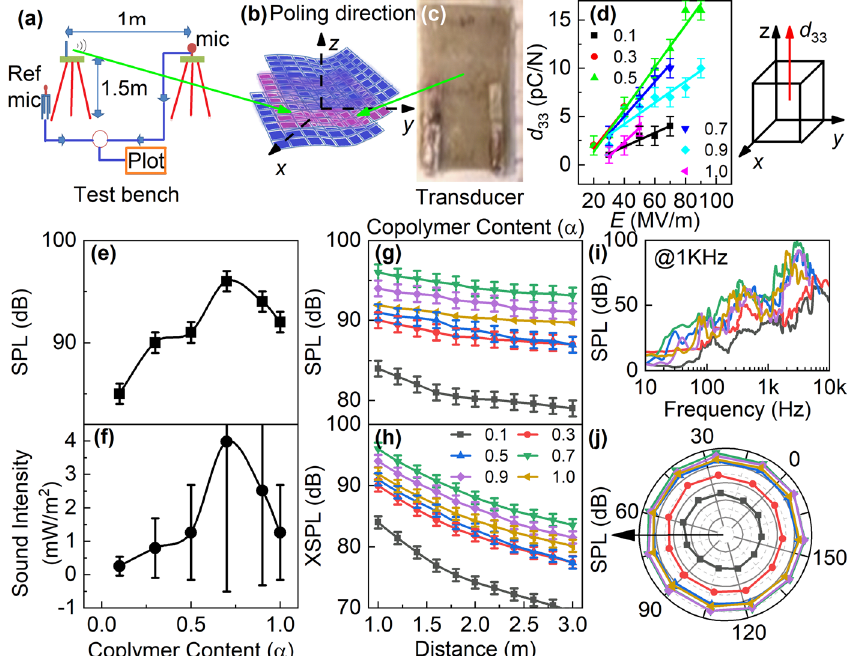
Fig. 5 Transduction and piezoelectric properties. a Schematics of the test con fi guration for acoustic measurement of the transparent thin fi lms according to ISO standard. b Poling direction of the device. c Image of actual transducer laminate. d Piezoelectric coef fi cient of polymer blends. e SPL comparison at 1 m distance at 100 Vpp. f Sound intensity (Wm − 2 ) graph at 1 m distance at 100 Vpp. g SPL graph with respect to distance. h The inverse law for attenuation of sound with respect to distance. i SPL with respect to the sampling frequency at 1 kHz. j Polar graph of SPL of polymer blends at 1 kHz. Error bars = standard deviation ( n = 6).